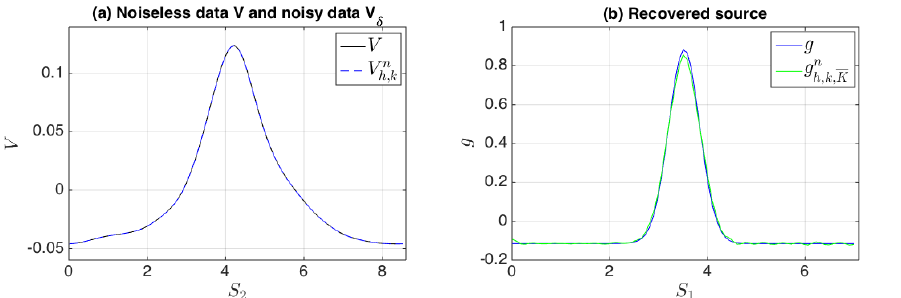
(blue). ( b ) Exact source g (blue) h , k